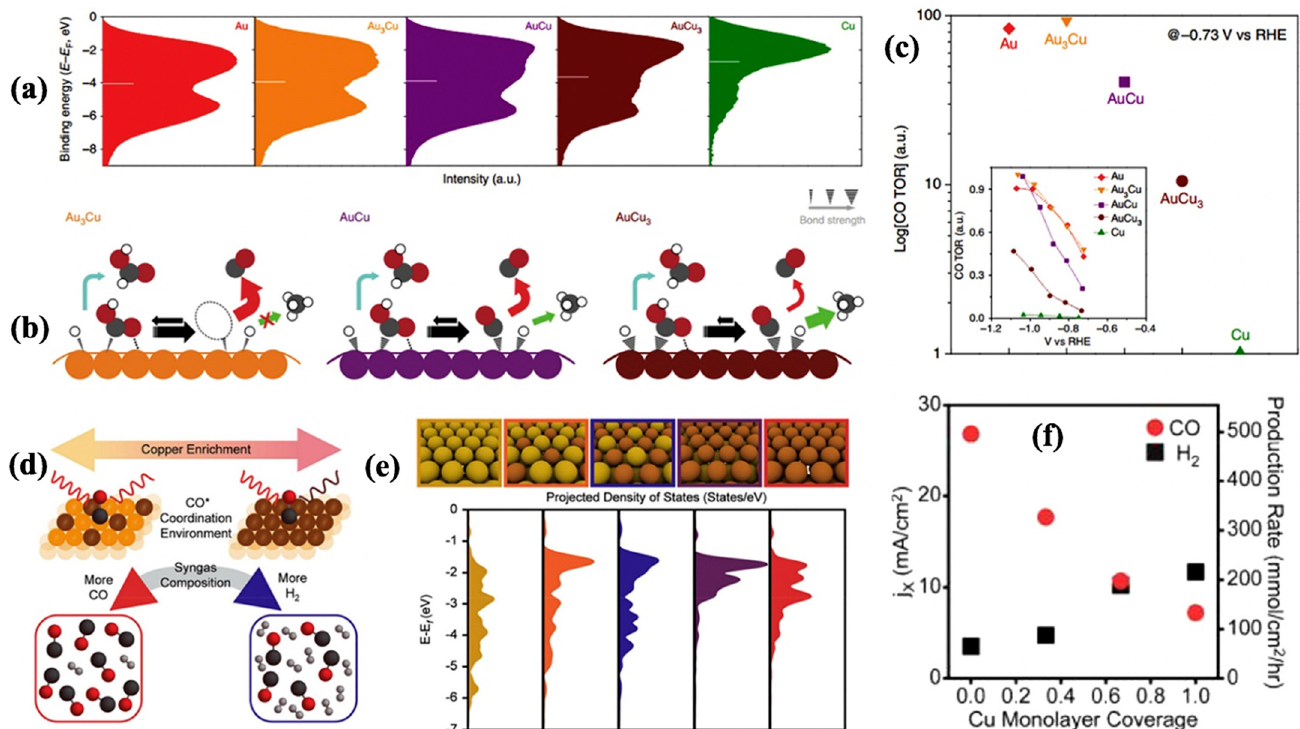
Figure 1. Characterization and performance of Cu–Au catalysts for the CO 2 RR. ( a – c ) Surface valence-band photoemission spectra of Au–Cu bimetallic nanoparticles (the white bars indicate the d-band centers) ( a ); proposed mechanism for the CO 2 RR on the surface of Au–Cu bimetallic nanoparticles (gray, red, and white atoms represent C, O, and H, respectively) ( b ); CO generation rate on various alloy electrocatalysts at a certain overpotential (inset shows relative CO generation rate as a function of the applied potential) ( c ). (Reprinted with permission from Ref. [51]. Copyright 2015 American Chemical Society). ( d – f ) Scheme depicting the relationship between the Cu-enriched Au surface, in situ characterization of CO* coordination, and syngas composition ( d ); calculated d-band electronic states for increasingly Cu-enriched Au surfaces ( e ); partial current densities (left axis) and production rates (right axis) for CO and H 2 as a function of Cu monolayer deposition on Au ( f ). (Reprinted with permission from Ref. [64]. Copyright 2017 American Chemical Society).